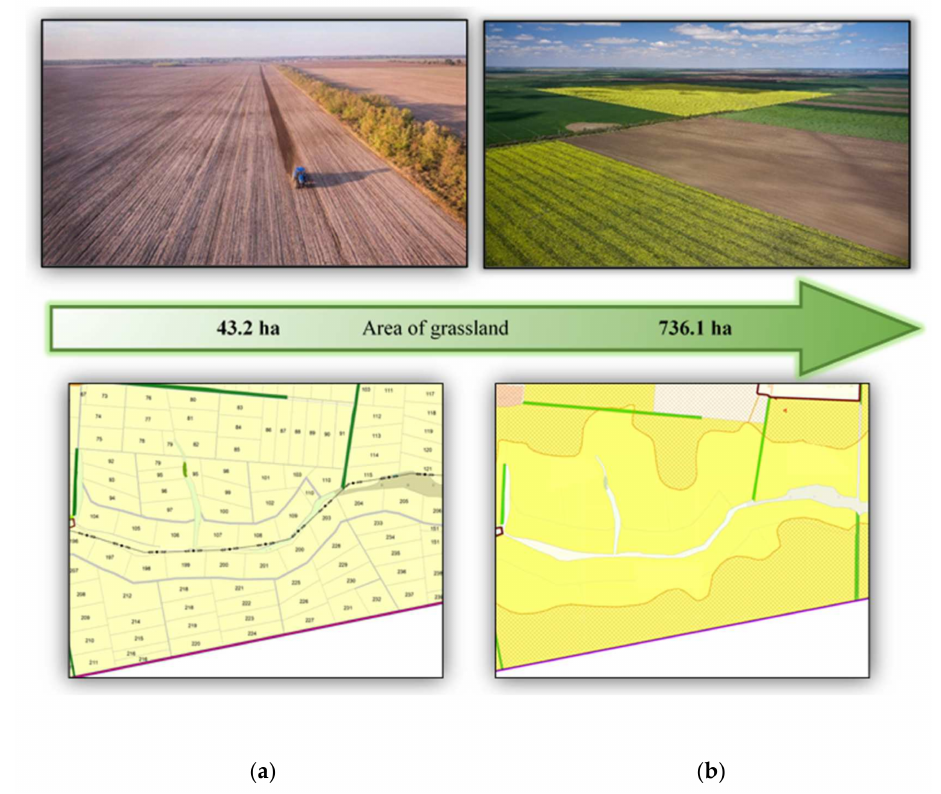
Figure 5. Measures of grassing within the farming enterprise territory according to the land reclama- tion scenario (photo: [51,52]: ( a ) Baseline scenario; ( b ) Land reclamation scenario.